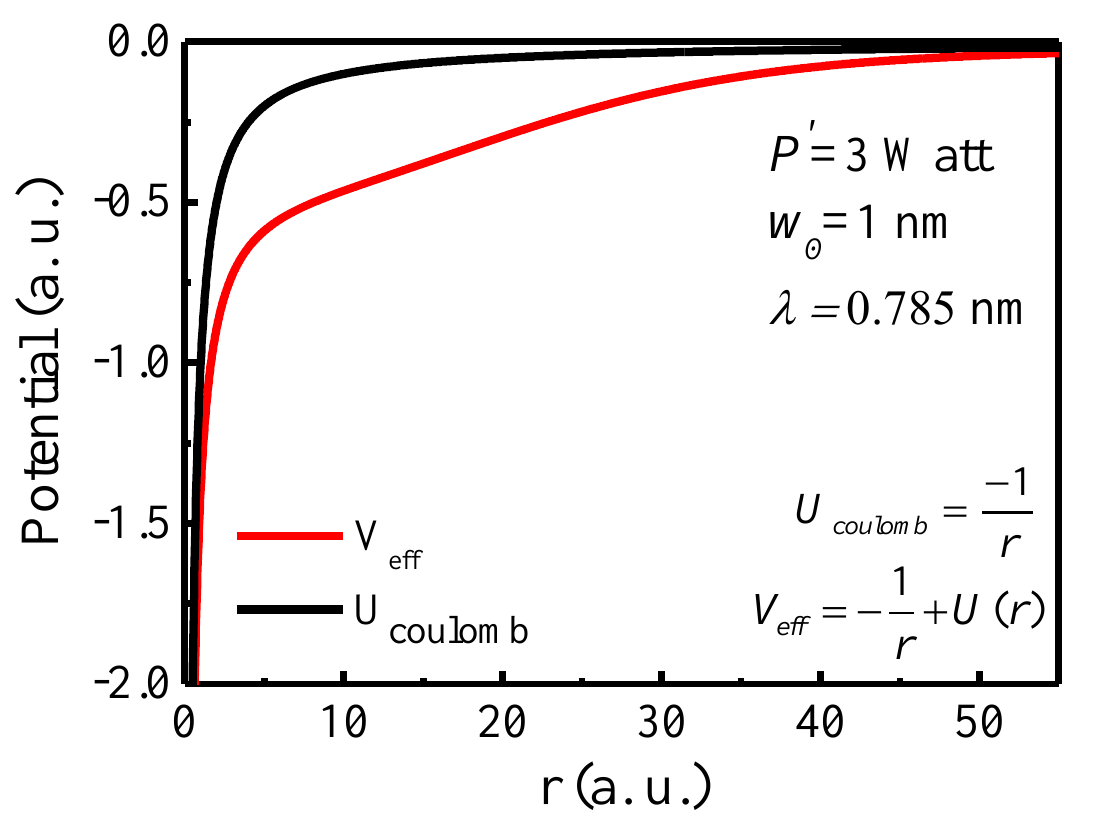
Figure 2. The effective potential of H (black) and H@XFEL (red) atom. For a multi-electron system, the potential given in Equation (6) is added to the original Dirac–Hartree–Fock (DHF) equation [41] and then solved by the equations using the self- consistent method. The modified Dirac–Hartree–Fock (DHF) orbital’s wavefunction u i (